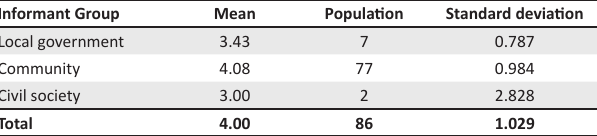
TABLE 5: Perceived threat by informant groups (mean scores).